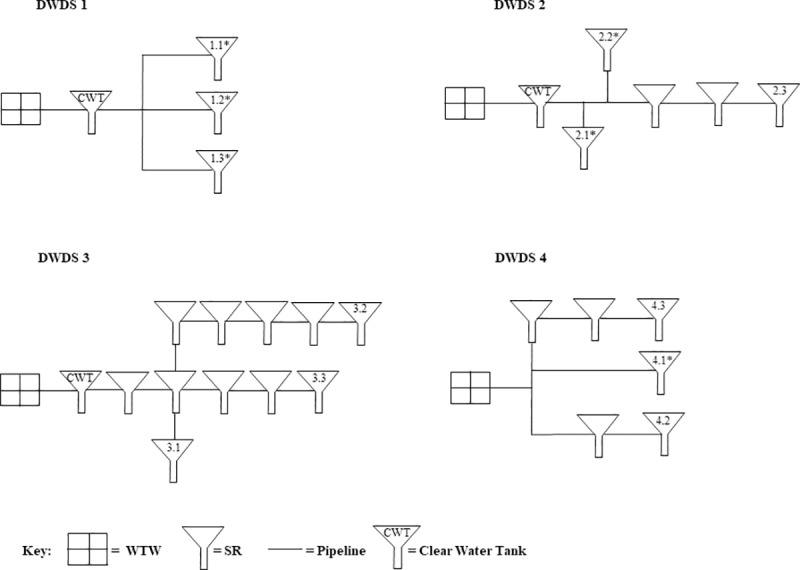
Schematic of the arrangement of service reservoirs (SR) within the four DWDS selected for further sampling (not to scale).The SRs sampled for AOC are numbered from one to three in each distribution system, as indicated by the second number in each case with the first number denoting the DWDS to which the SR belongs. Unlabelled SRs are not sampled as part of this study and are only drawn to show the pathway of the water. SRs labelled with a * are subject to the pipe only effect, as water has not previously passed through a SR. Samples analysed included: WTW (raw): AOC, TCC & ICC; WTW (post-treatment): AOC, TCC, ICC & total chlorine; SR inlets: AOC; SR outlets: AOC, TCC, ICC & total chlorine.